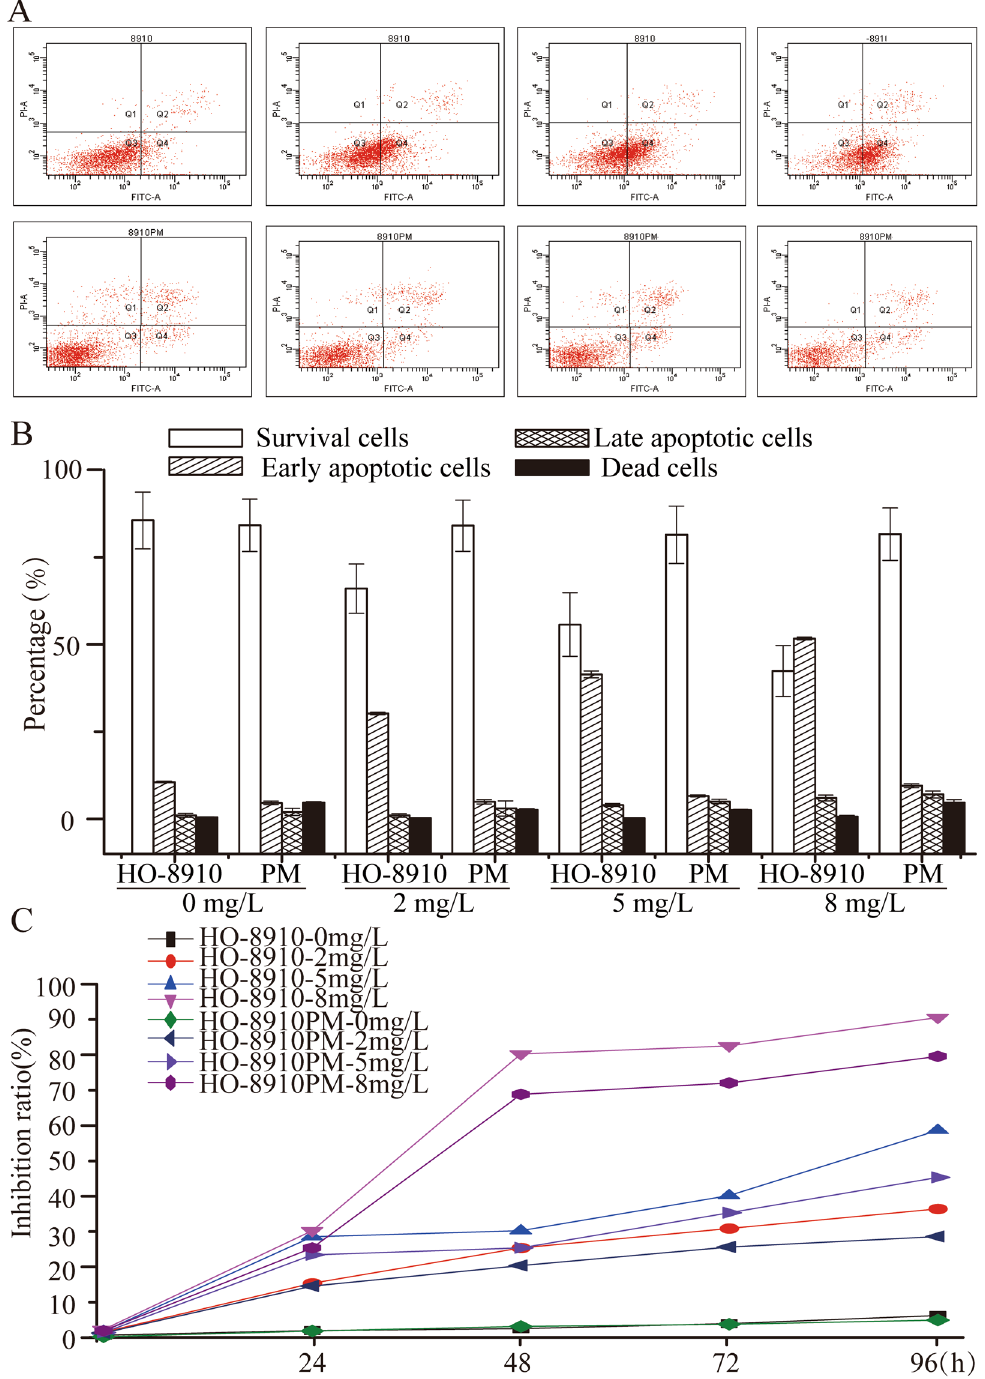
Figure 6. High expression of HOXD8 in HO-8910PM cell line make them cisplatin-resistant. Analysed by flow cytometry ( A ), HO-8910 (upper panel) and HO-8910PM (lower panel) were treated with 0, 2, 5, or 8 mg/L of cisplatin. Q1, Q2, Q3, Q4 represent dead cells, late apoptotic cells, survival cells, and early apoptotic cells, respectively. At different concentrations of 0, 2, 5, or 8 mg/L, these two cells have significant differences in cisplatin resistance ( p < 0.05) ( B ). Growth curves of HO-8910 and HO-8910PM ( C